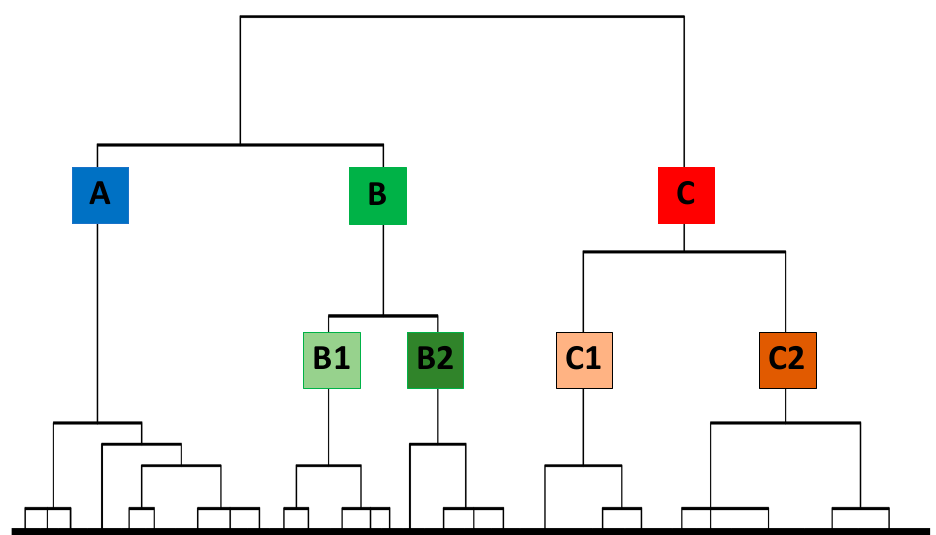
Figure 1. Dendrographic representation of hierarchical cluster analysis of subjects, based on respondents’ score for each PC. The letter represents the different groups.